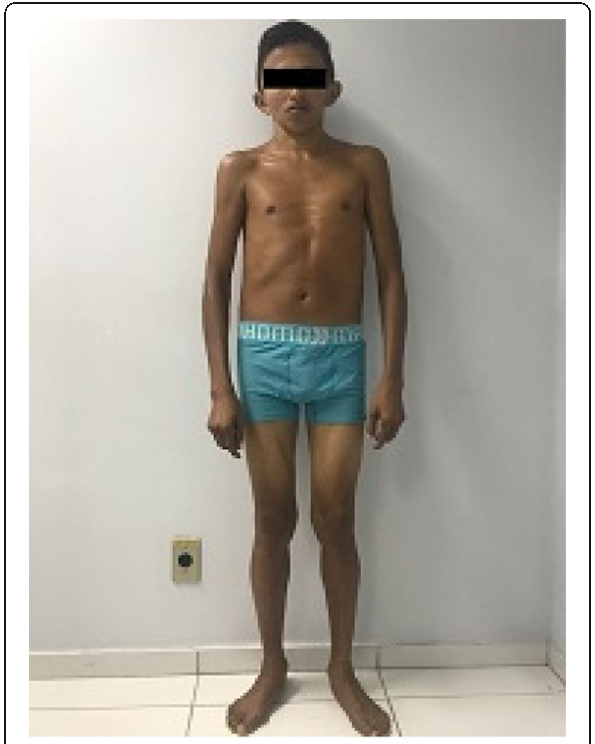
Fig. 1 (abstract P331). PATIENT WITH LOW IMPLANTATION OF THE EARS, MICROGNATISM, MUSCLE HYPOTROPY, ATROPHY OF QUADRICEPS AND UPPER AND LOWER MEMBRES IN